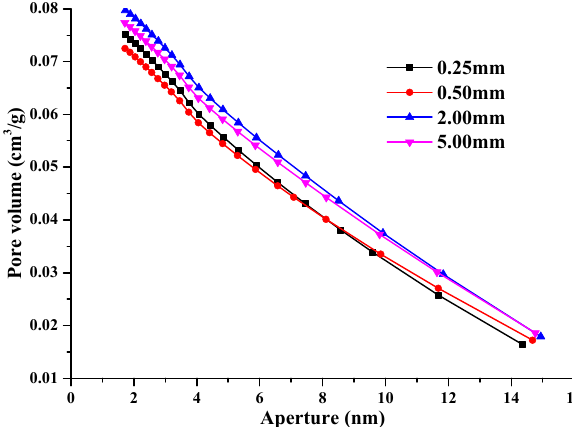
Figure 5. BJH adsorption cumulative pore volume.